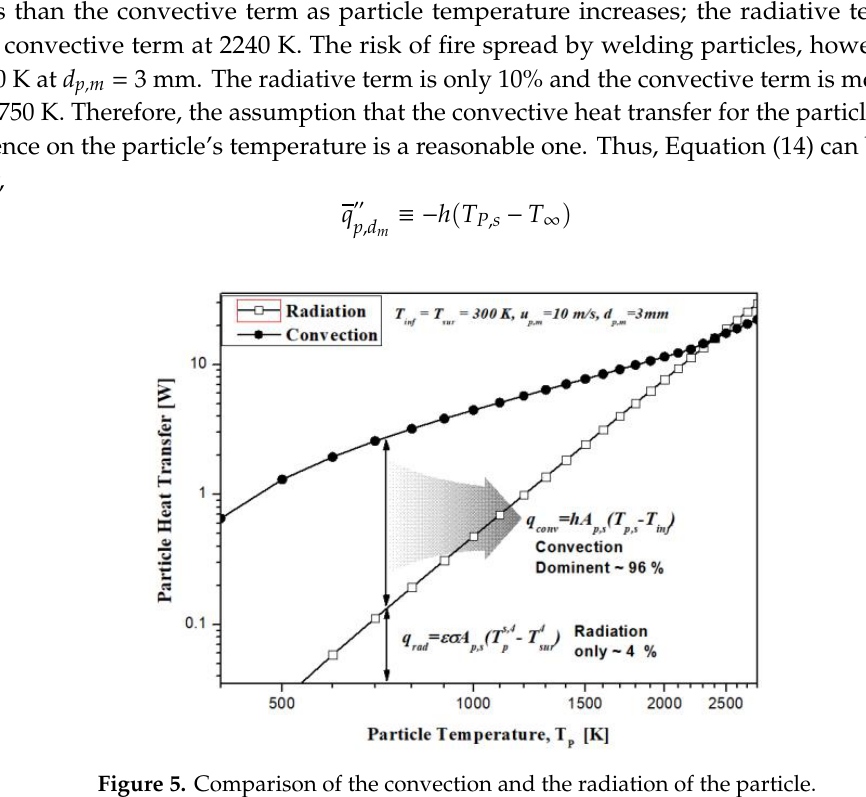
Figure 5. Comparison of the convection and the radiation of the particle.